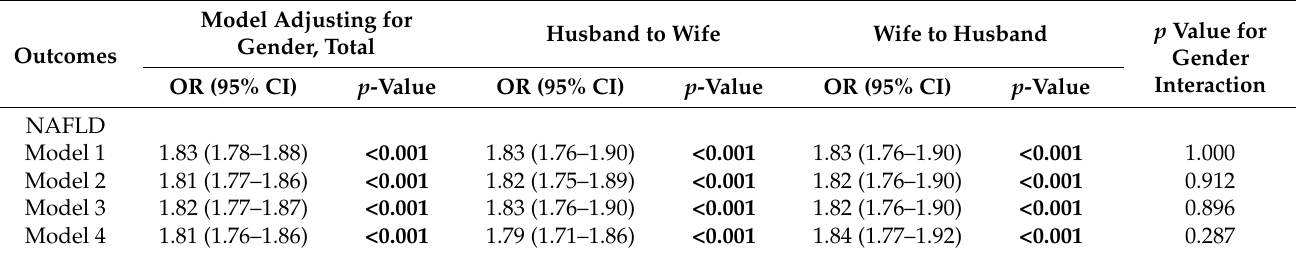
Table 3. Reciprocal NAFLD association among the 58,122 older couples for the period 2018–2020.